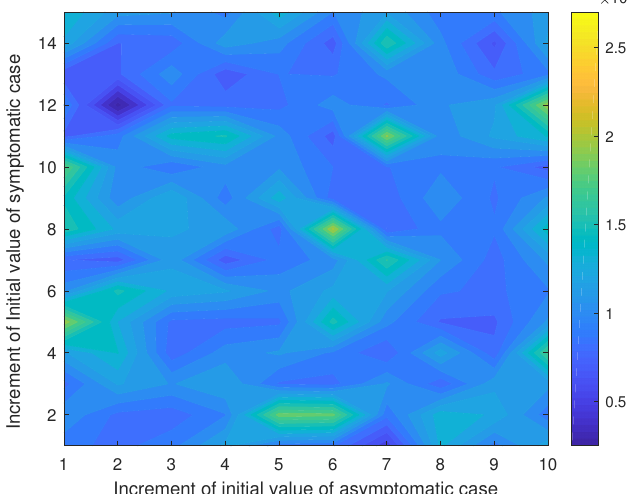
Figure A1. Variation of the starting point for optimization algorithm on the absolute errors of predicted cumulative number of reported cases at the end of the first phase.